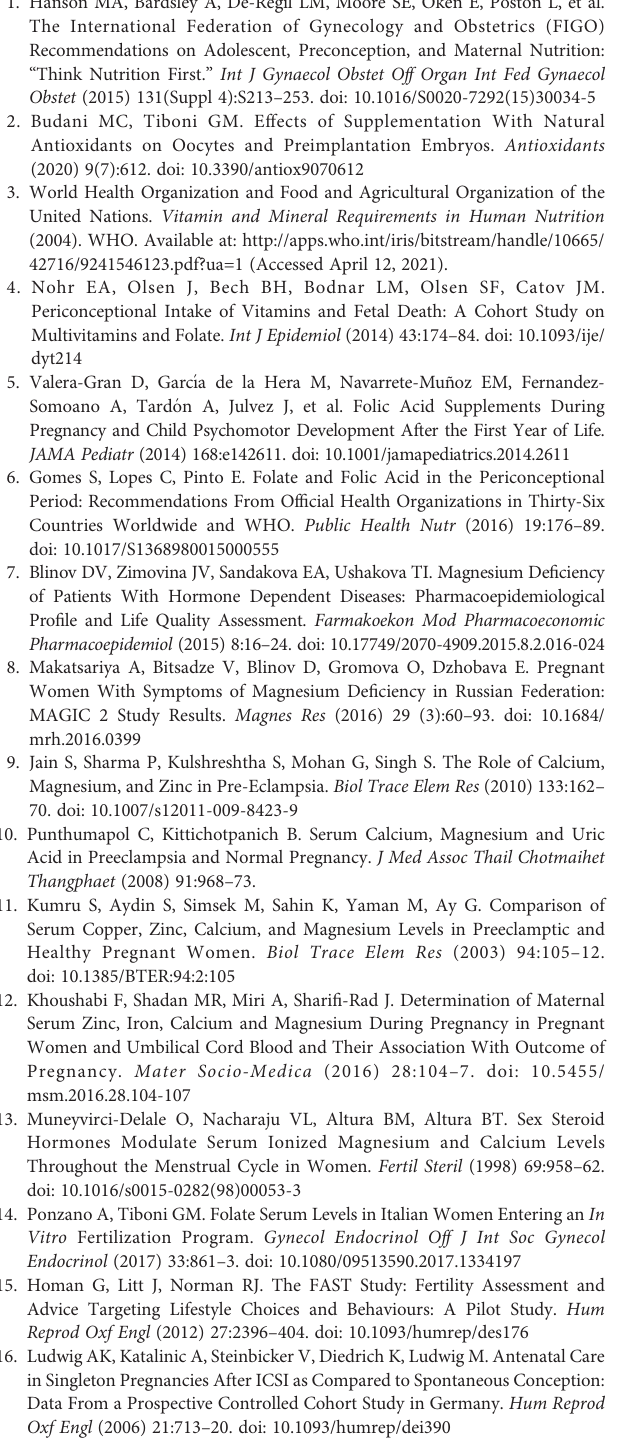
(B) Matureoocytes,adjustmentfor continuousBMI, baselineserum AMH andAPTT, durationofstimulationanddoseofFSH. (C) Fertilizedoocytes,adjustmentforcontinuous BMI, baselineserumAMHandAPTT,